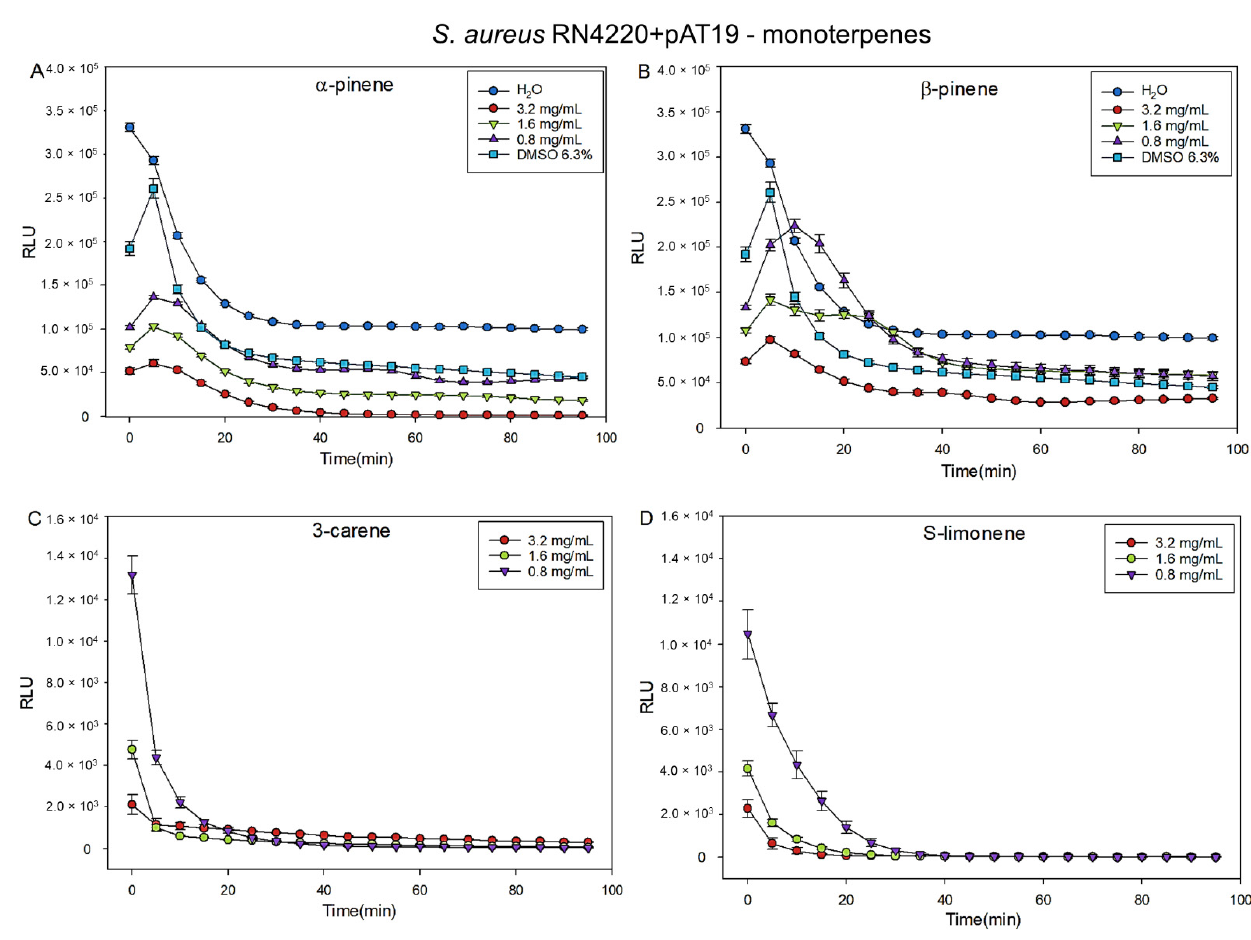
Figure 7. Effect of the monoterpenes ( A ) α -pinene, ( B ) β -pinene, ( C ) 3-carene, and ( D ) S-limonene for the viability of continuously luminescent light producing biosensor strain S. aureus RN4220+pAT19. The highest content of DMSO 6.3% found in the highest concentration (3.2 mg/mL) of monoterpenes is drawn as a control in A and B. The figure shows the relative light unit (RLU) averages of the triplicates in the microplate. Lower the RLU aka light production values, the more efficient the terpene in question is in inhibiting the bacterial metabolism indicating antibacterial activity. The error bars represent the standard deviations of the sample triplicates.